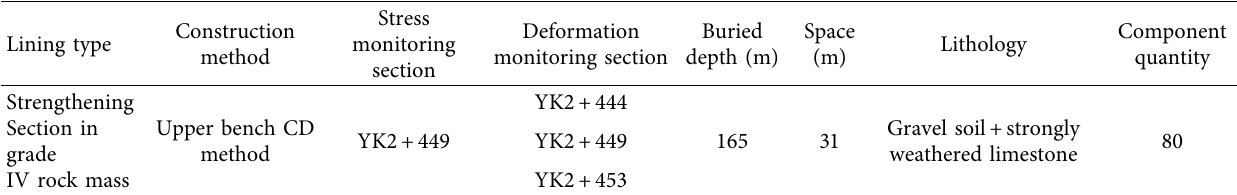
Table 2: Site section monitoring scheme.